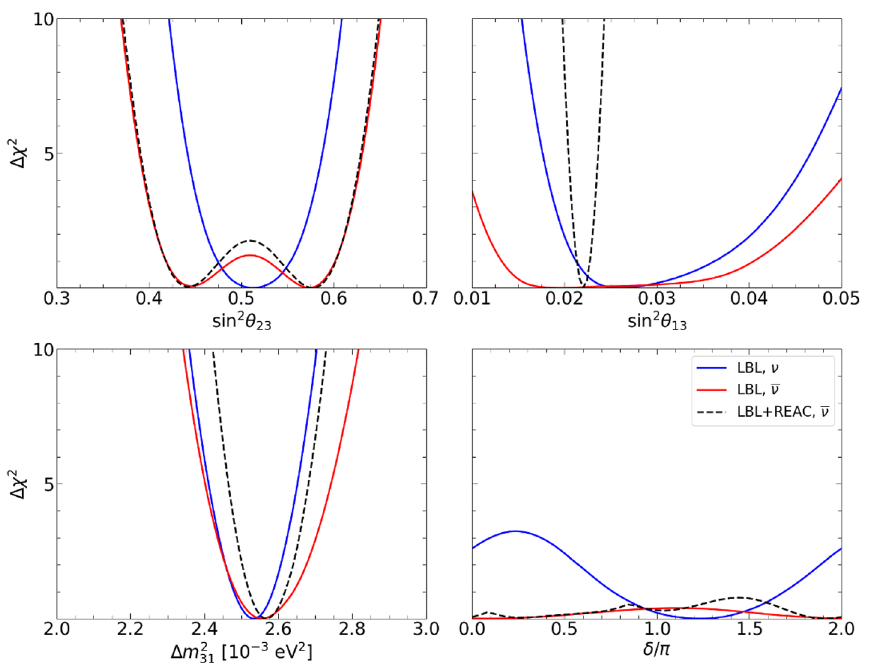
from long-baseline accelerators alone (red) and combining with reactors (black dashed) for the atmospheric mixing angles (upper left), reactor mixing angles (upper right), atmospheric mass splittings (lower left) and CP phases (lower